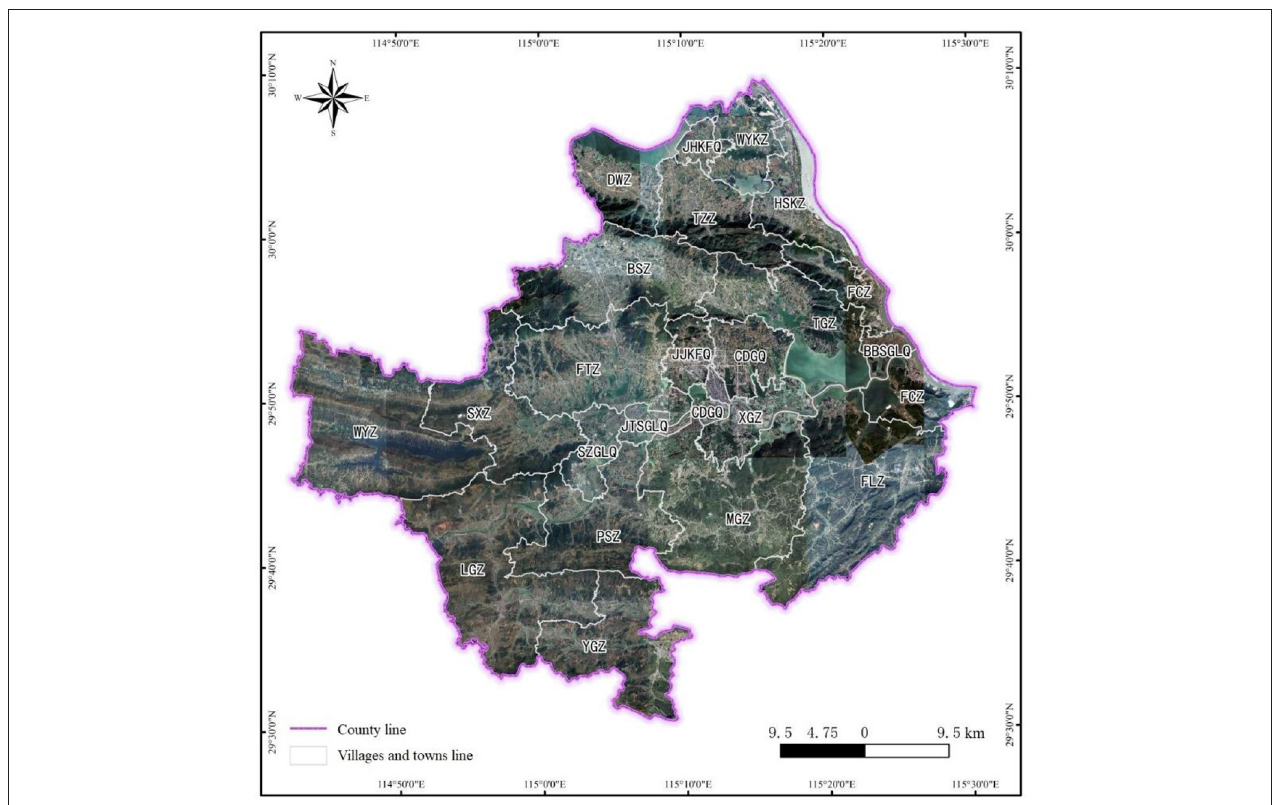
FIGURE 8 | Schematic diagram of geographical location of the study